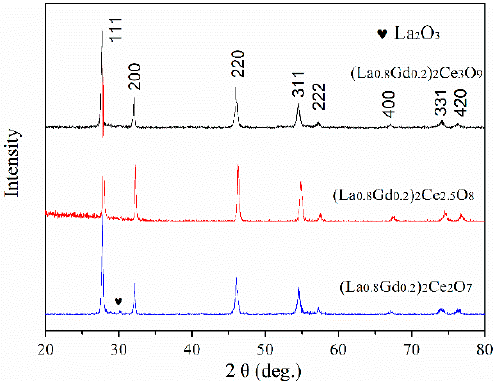
Figure 1. X RD patterns of the coatings deposited using three spray powders with different compo- Figure 1. XRD patterns of the coatings deposited using three spray powders with different sition.